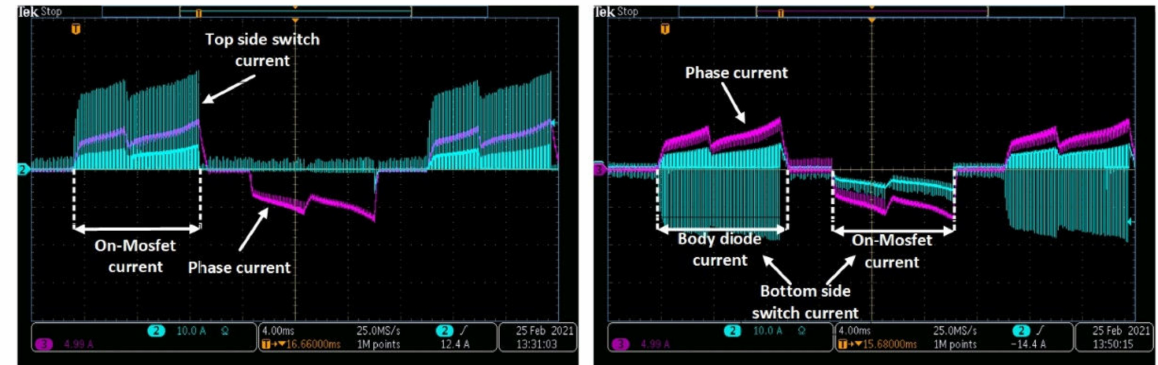
Figure 6. Top- and high-side switchcurrent waveform from experimental